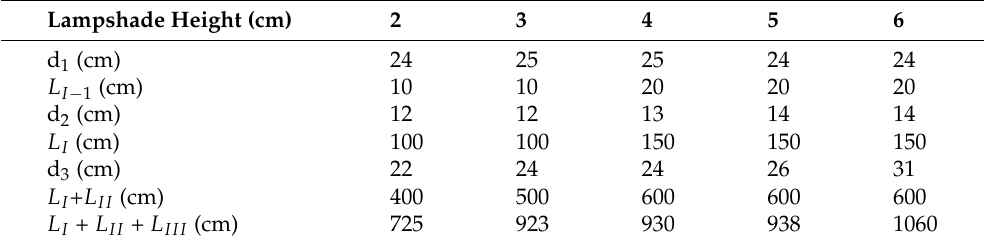
Table 2. Experimental data.